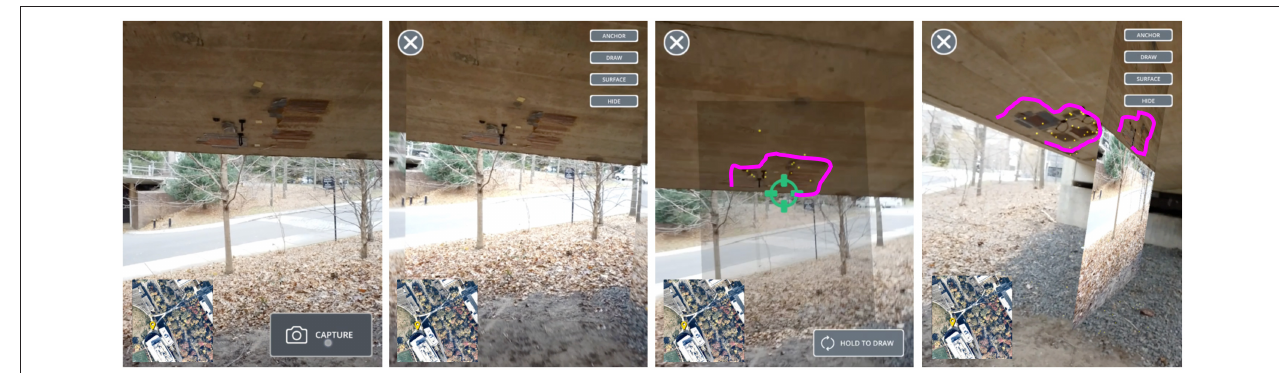
FIGURE 10 | Screen shots of the application utilized for structural health monitoring. The first panel shows the initial capture scene, the second panel shows the annotation screen with the captured image, the third panel shows the annotation being taken on the point cloud, and fourth panel shows the annotation projected back onto the image for off site viewing.